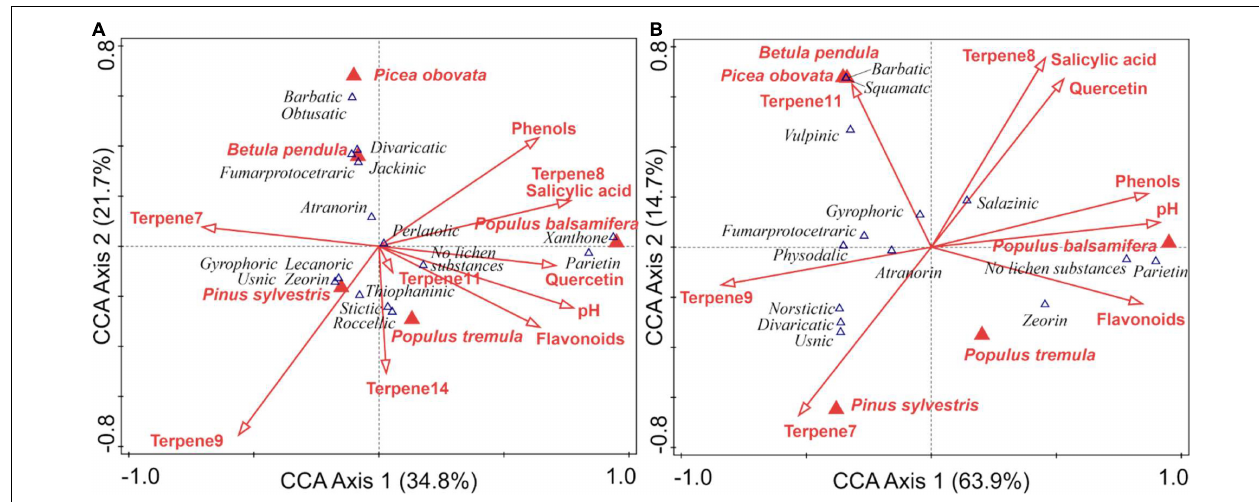
FIGURE 5 | Canonical correspondence analysis (CCA) ordination plot showing the cover of lichens containing different secondary metabolites in relation to phorophytes and their chemical properties. (A) Crustose species, (B) foliose and fruticose species. Bark metabolites found in several phorophytes are shown. acid-containing species on acid bark in our research may